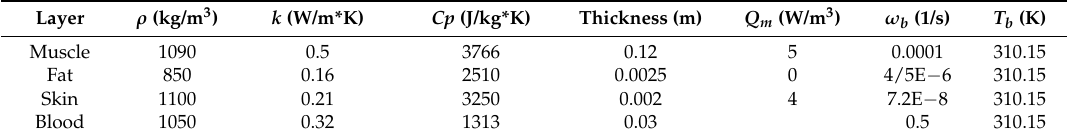
Table 1. Human tissue layer properties.